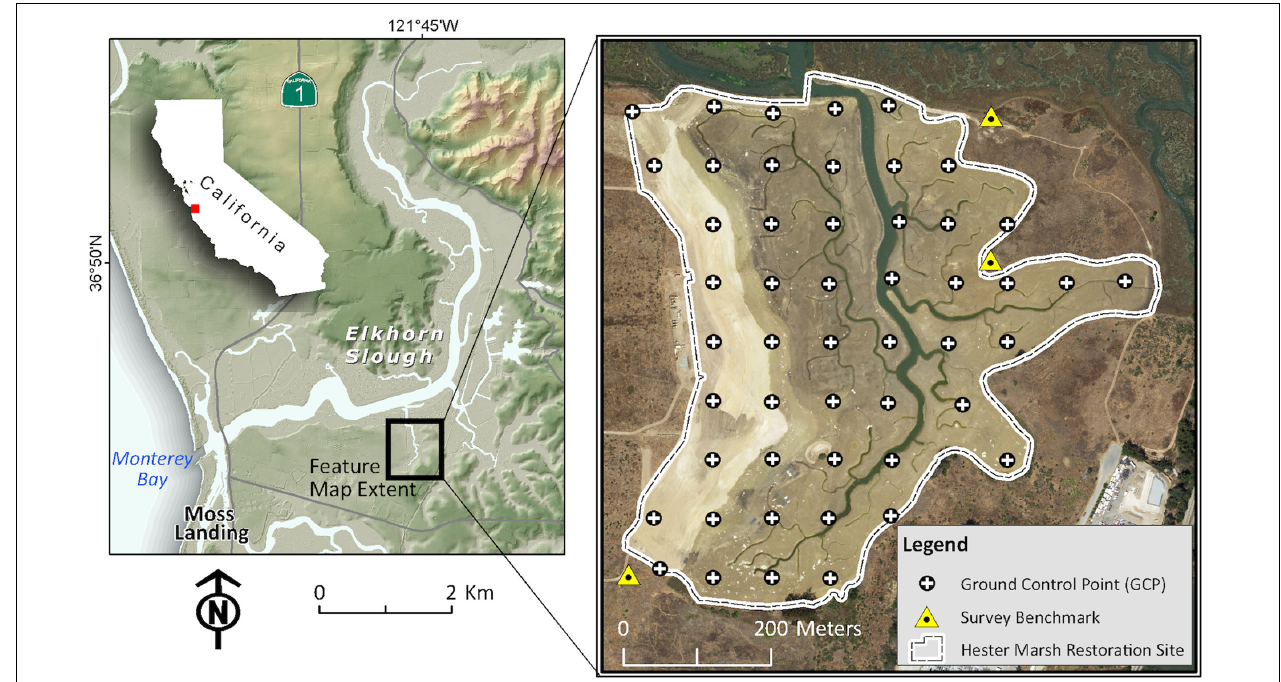
FIGURE 1 | Map of the Hester Marsh restoration site in Elkhorn Slough, an estuary in Central California, United States. A grid of ground control points (GCPs) was established for linking UAV imagery to known locations on the ground. Elevations were surveyed at GCPs and referenced to survey benchmarks to create digital elevation models. TABLE 1 | General information for UAV flights conducted at six different altitudes for the GCP density and vegetation-flight altitude experiments. Altitude (m) Flight time Orthomosaic Images per ha Total file size of all Total file size of (min/ha) resolution (cm) (#) images (MB) orthomosaic